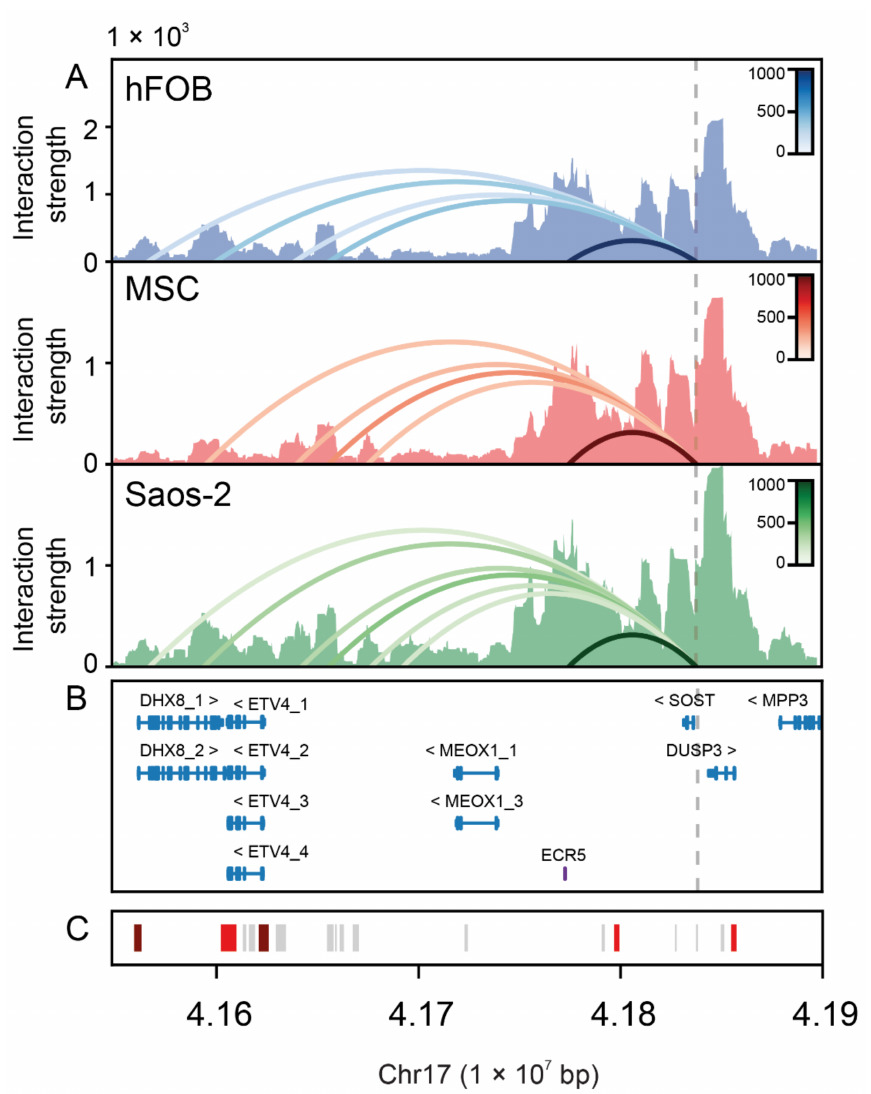
Figure 3. Chromatin interactions of the SOST proximal promoter region as detected by 4C- seq in human fetal osteoblasts (hFOB), mesenchymal stem cells (MSC) and the Saos-2 cell line. Panel ( A ): Graphical representation of a 350-kb Chr.17 region containing SOST and all the genomic elements found to interact with it displaying both the read depths (Interac- tion strength) and their corresponding significance (arched lines). The dashed vertical line marks the SOST promoter, used as the viewpoint. Color scale corresponds to the strength of the significant interactions. Panel ( B ): Genes in this region: DHX8_1 (ENST00000262415.3), DHX8_2 (ENST00000540306.1), ETV4_1 (ENST00000319349.5), ETV4_2 (ENST00000545954.1), ETV4_3 (ENST00000591713.1), ETV4_4 (ENST00000545089.1), MEOX1_1 (ENST00000520305.1), MEOX1_3 (ENST00000393661.2), SOST (ENST00000301691.2), DUSP3 (ENST00000226004.3), MPP3 (ENST00000398389.4) from GRCh37/hg19. In purple the ECR5 position [35]. Panel ( C ): Representa- tion of the GeneHancer (GH) track (enhancers -grey- and promoters